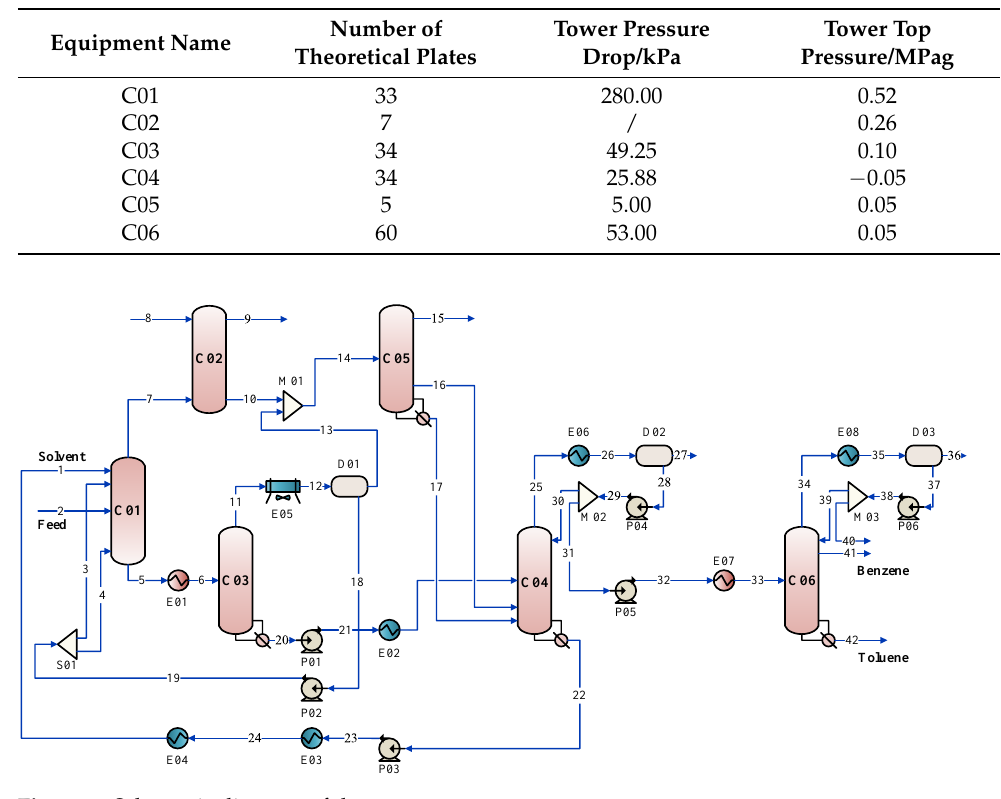
Figure 7. Schematic diagram of the process. Table 4. Tower equipment parameters.